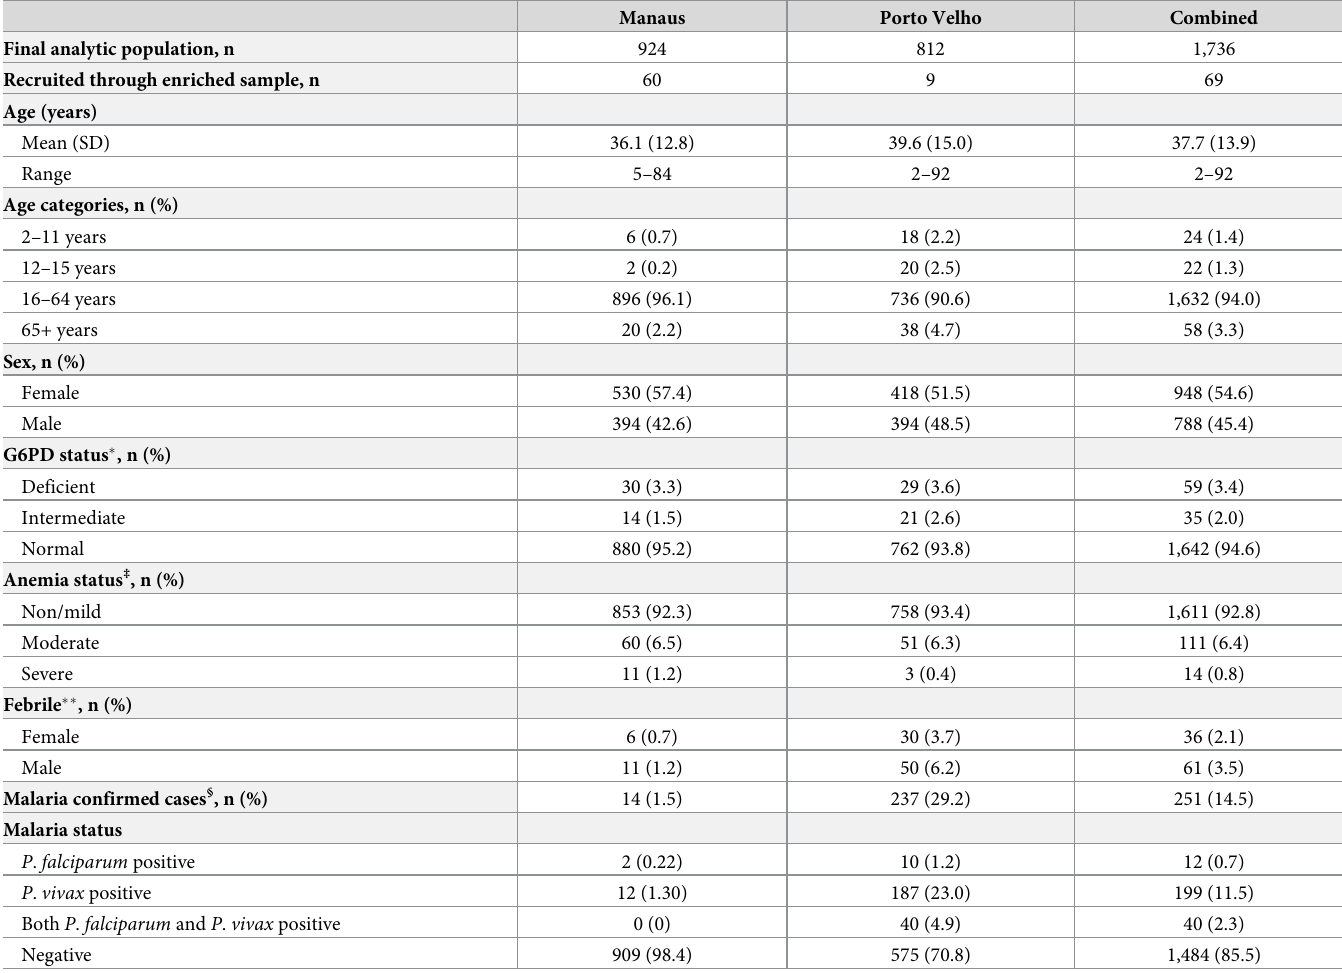
Table 2. Characteristics of the study